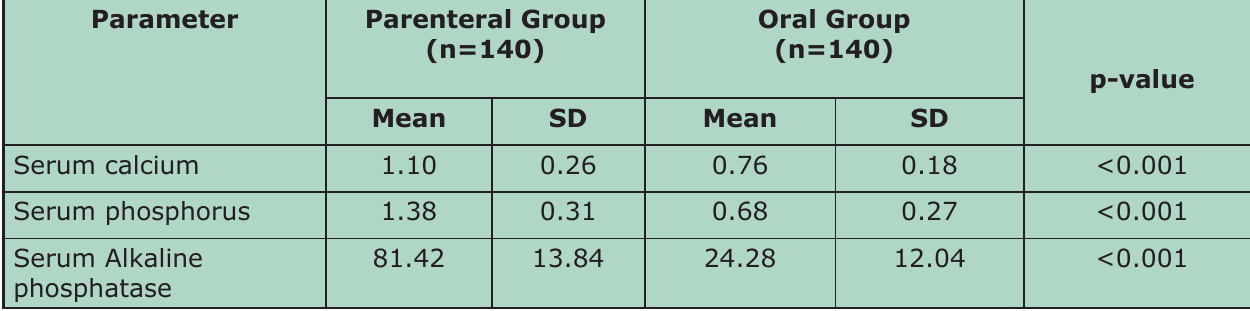
Table-V: Stratification comparison of parental and oral vitamin D supplementation in the treatment of nutritional rickets regarding age (n=280)Age:1-2